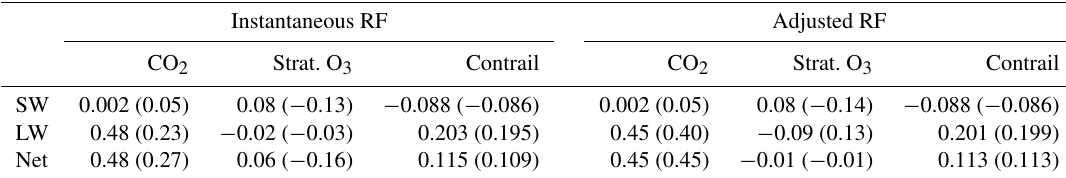
Table 2. Annually and globally averaged shortwave (SW), longwave (LW), and net instantaneous and stratosphere-adjusted radiative forcing at the tropopause due to changes in CO 2 and stratospheric O 3 between 1980 and 2000 and due to additional homogeneous 1% contrail cover. The respective values of the radiative forcing at TOA are given in parentheses.